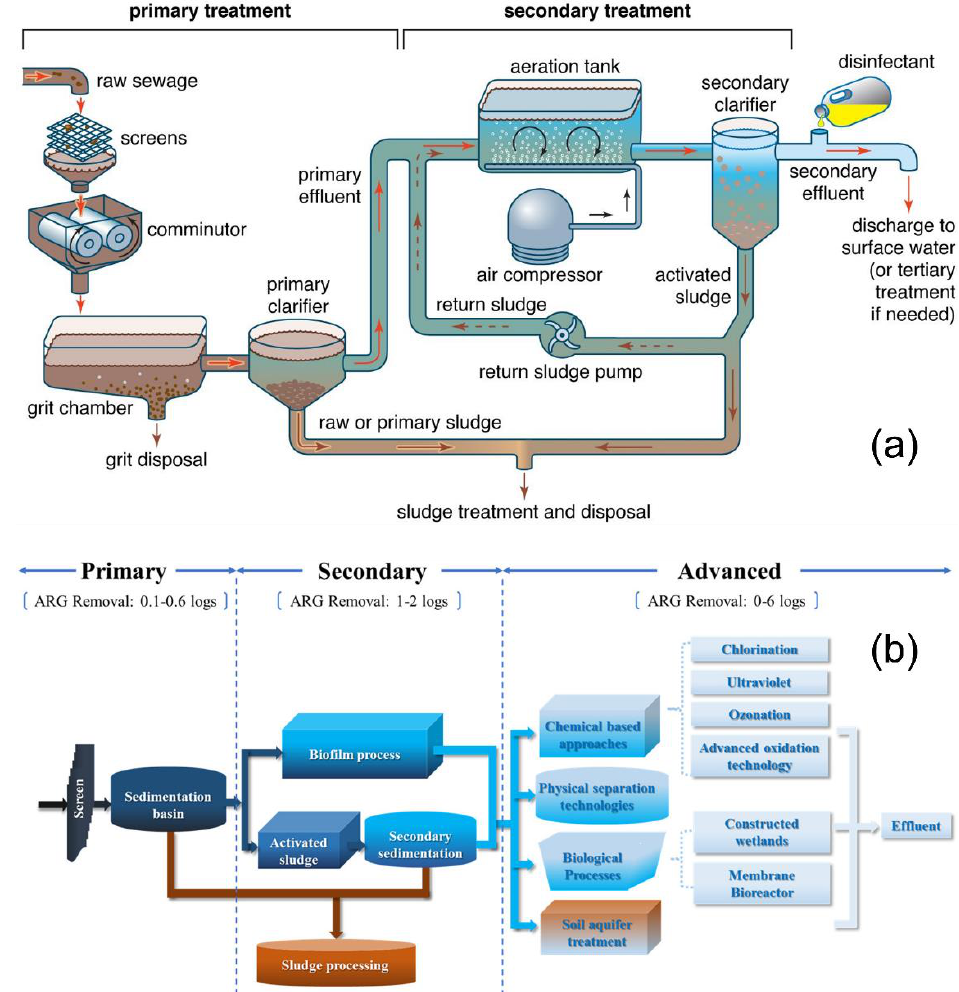
Figure 1. ( a ) Wastewater treatment steps [18], showing ( b ) the removal efficacy of antibiotic re- sistance genes (ARG) (emerging contaminants) in this step [19]. genes (ARG) (emerging contaminants) in this step